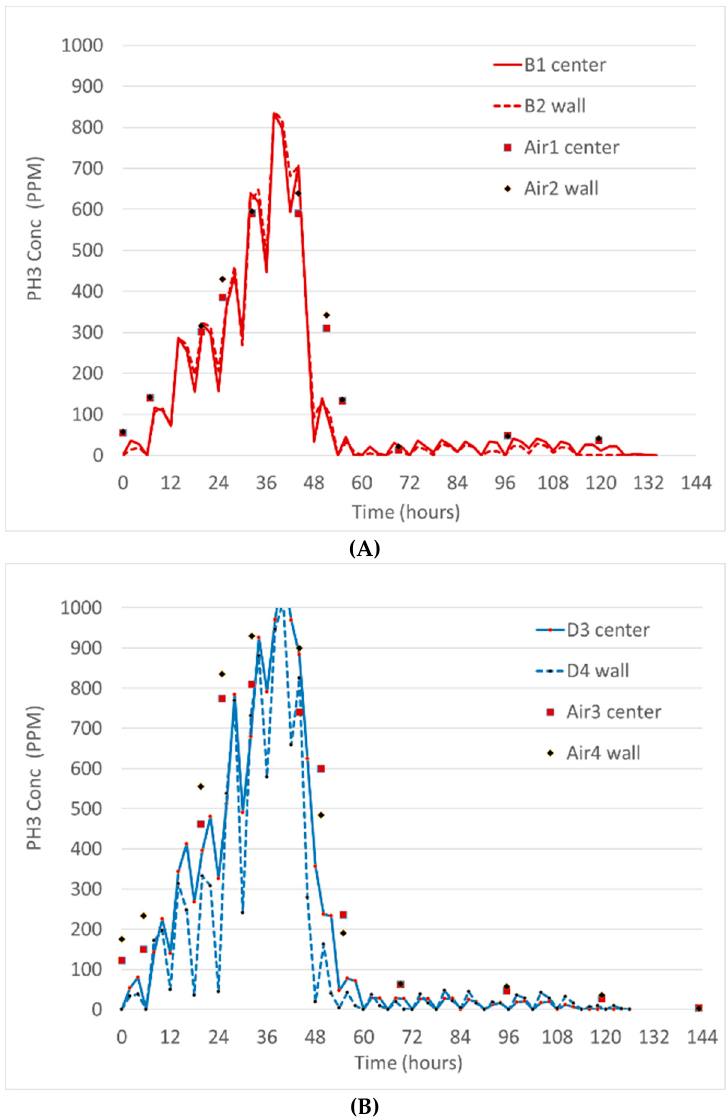
Figure 7. Fumigation Trial #3. ( A ) Bin B with 640 Phostoxin tablets distributed on grain surface with periodic operation of recirculation fan. ( B ) Bin D was prepared, treated and monitored with sensors and airlines at the same time.